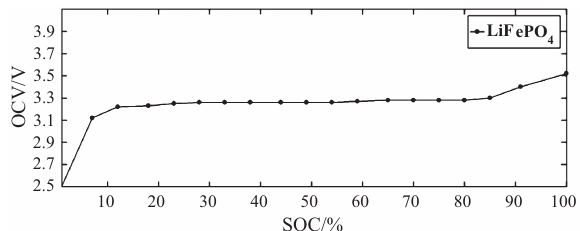
Figure 2. OCV-SOC relationship offaststaticcalibration